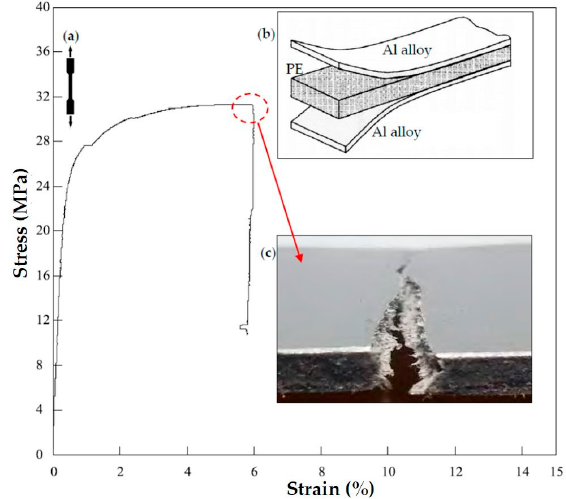
Figure 2. ( a ) Typical tensile curve of the sandwich composite; ( b ) Schematic diagram of the sandwich composite and ( c ) detail of a fractured specimen. Table 1. Mechanical properties of the sandwich composite.